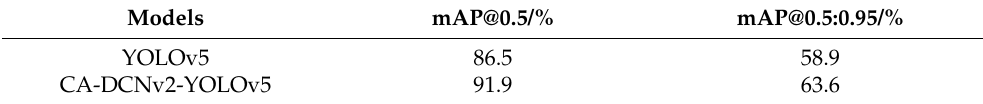
Table 5. Comparison of the detection e ff ect of the occluded target fruit before and after the improve- ment.